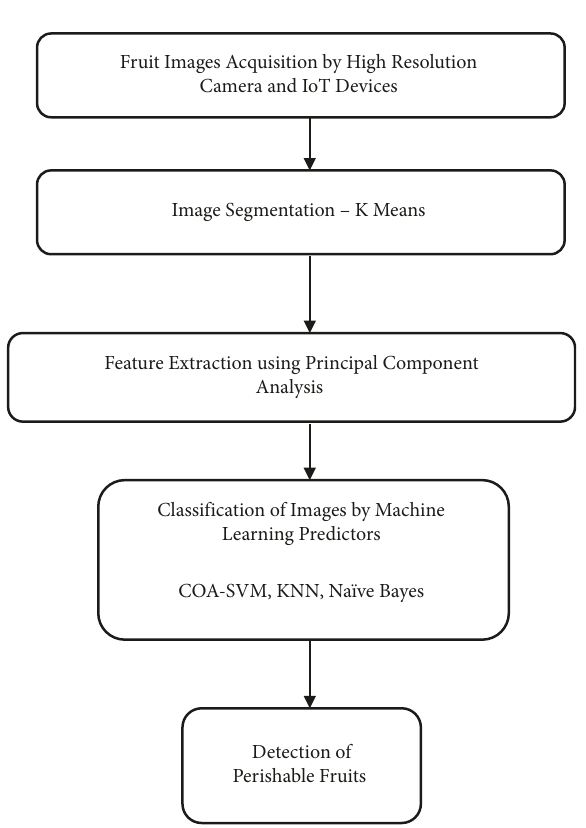
Figure 1: Internet of things, image processing, and machine learning-based model for monitoring perishable food